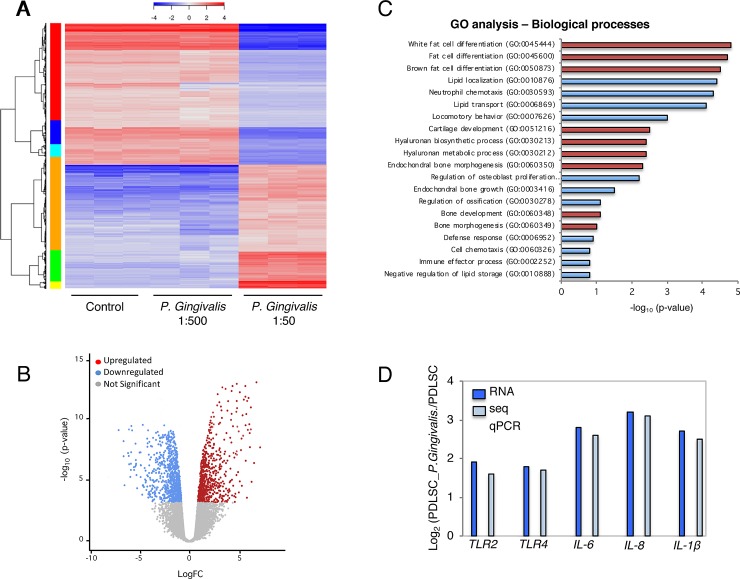
Transcriptomic analysis elucidates PDLSC response to bacterial supernatant-induced bioactivity.(A) Bacterial supernatant treated groups (1:500 and 1:50 dilutions) and untreated group (Ctrl) were marked. Heatmap showed significant gene profile for RNAseq data. Normalized log2 scale shown. (B) Volcano analysis was performed for significantly changed genes in the dilution of 1:50 supernatant treated group (red dots represented upregulated genes and blue dots represented downregulated genes, Fold change > 2.0, p < 0.05). (C) Significant GO terms of associated biological processes from differentially regulated genes from a ranking by enrichment scores (p < 0.05). Adipogenesis and chondrogenesis processes identified by red columns. Enrichment scores were calculated as −log10 (P-value), (D) Comparison between RNAseq and qPCR gene expression showed similar values.